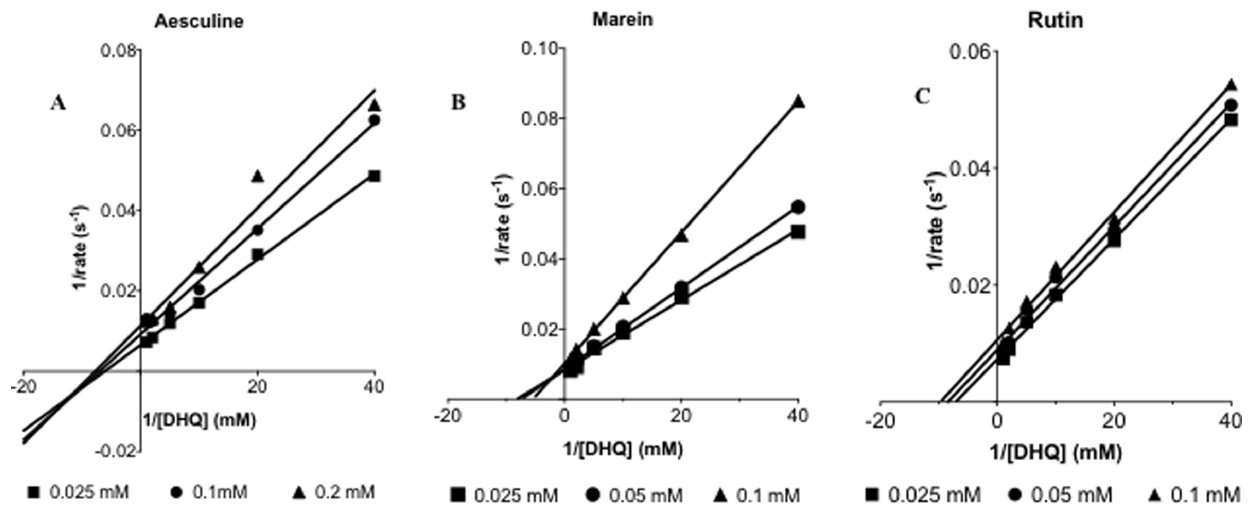
Figure 6. Double-reciprocal plots for three of the identified inhibitors targeting efDHQase. Plot for aesculine (A) and marein (B) showing two possible scenarios for mixed inhibition where the lines intersect either below the x-axis or just after y-axis respectively. Plot for rutin (C) showing uncompetitive inhibition where the lines run parallel to one another.